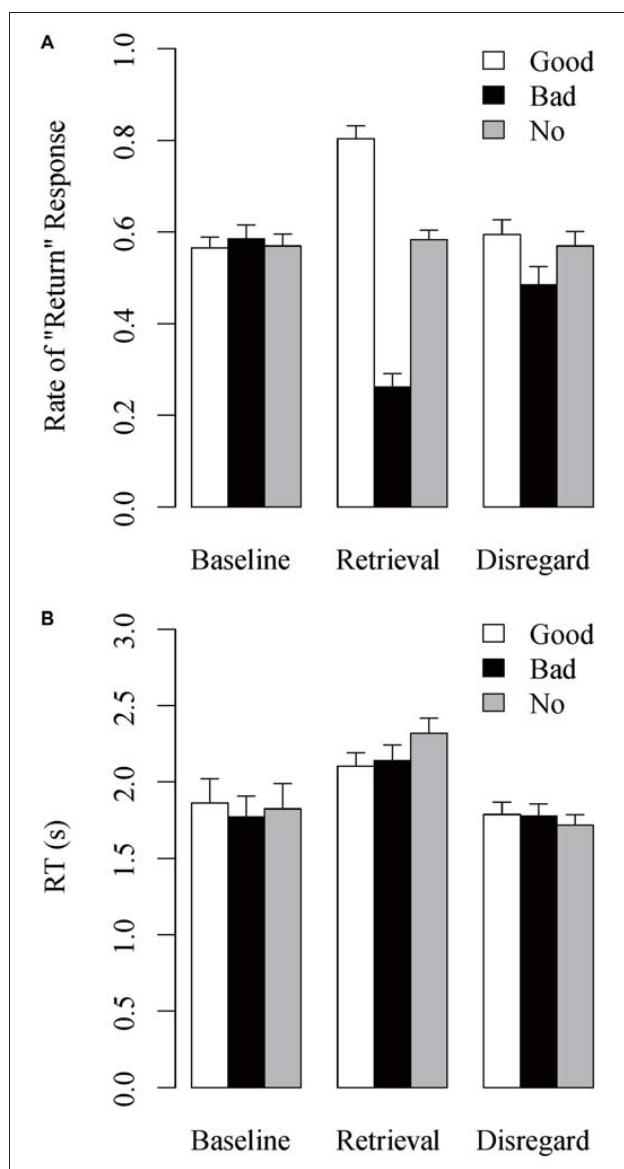
FIGURE 3 | Mean (A) rate of “return” response and (B) RT in the action-inference tasks as a function of reputation condition and task session . Error bars indicate standard errors of the